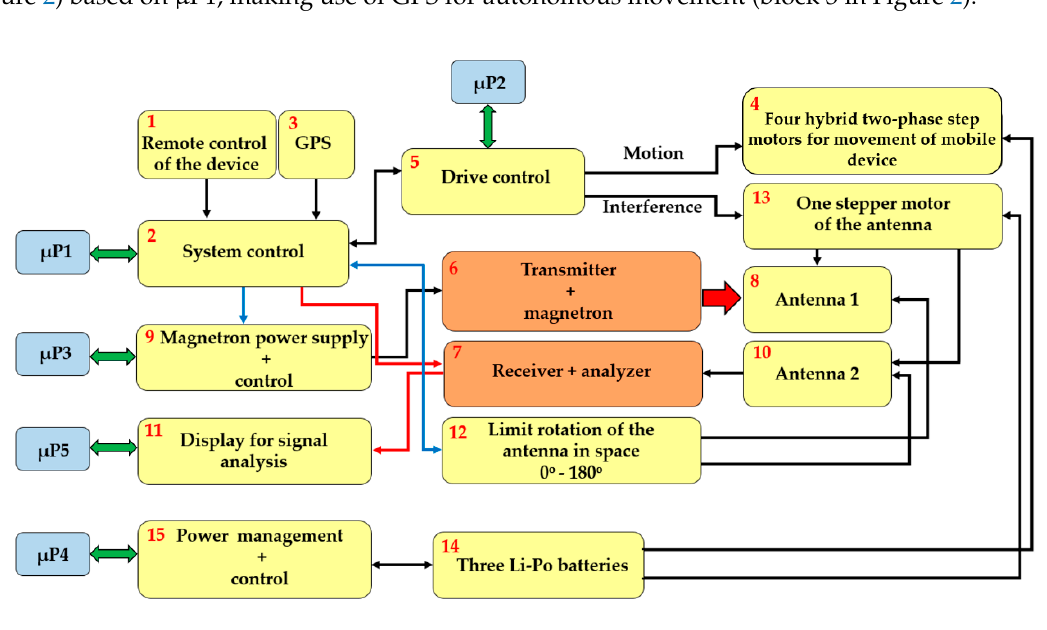
Figure 3. Displaying the power source of the individual accumulators.